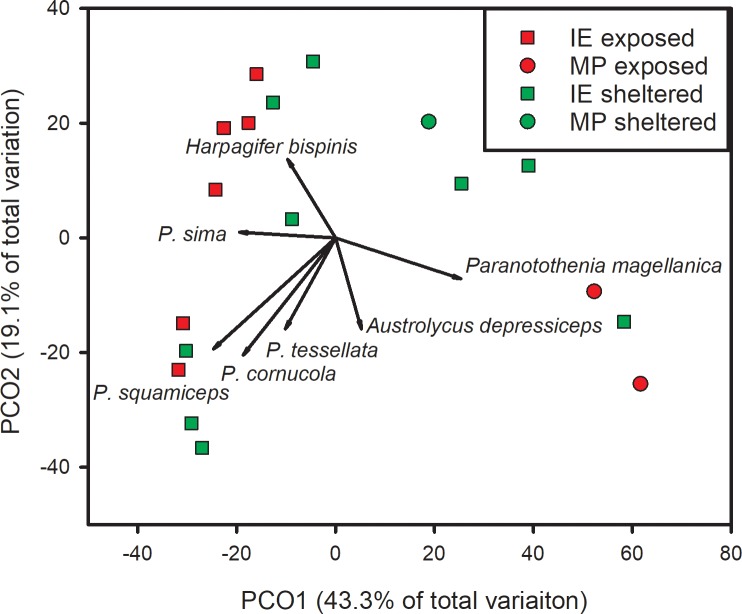
Principle coordinates analysis of fish assemblage composition based on density (number of individuals.m-2) by location.Data were ln(x+1)-transformed prior to analyses. Vectors are the relative contribution and direction of influence of fish assemblage components to the observed variation among sites (Pearson Product movement ≥ 0.5). P. = Patagonotothen spp.